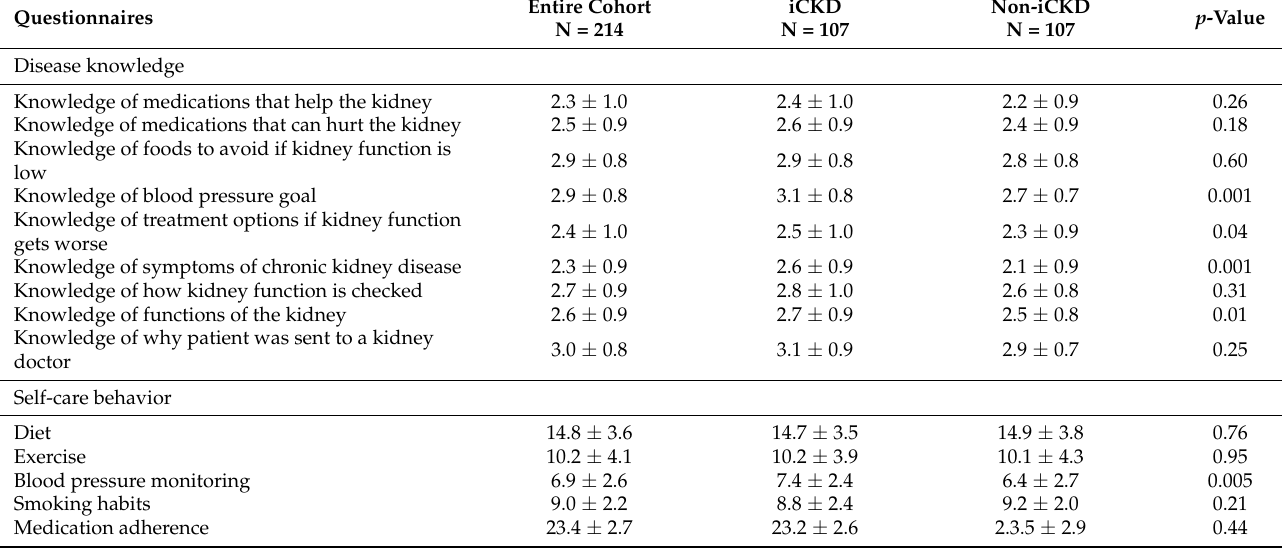
Table 2. The items of disease knowledge and self-care behavior between CKD patients with and without iCKD usage post propensity score